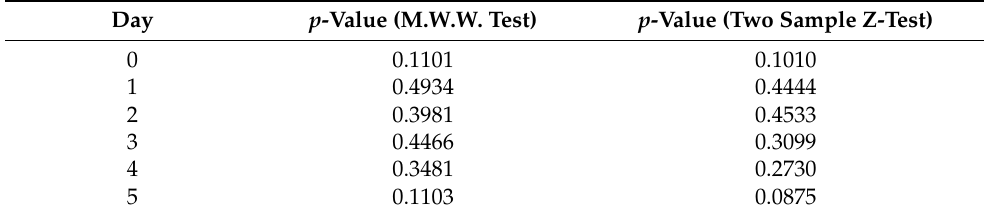
Table A4. Mann-Whitney-Wilcoxon test and the Two-Sample Z-test—Comparing Royal Dutch Shell and Exxon Mobil regarding the induced seismicity in the US and the Netherlands d ( df = 726). Day p -Value (M.W.W. Test)